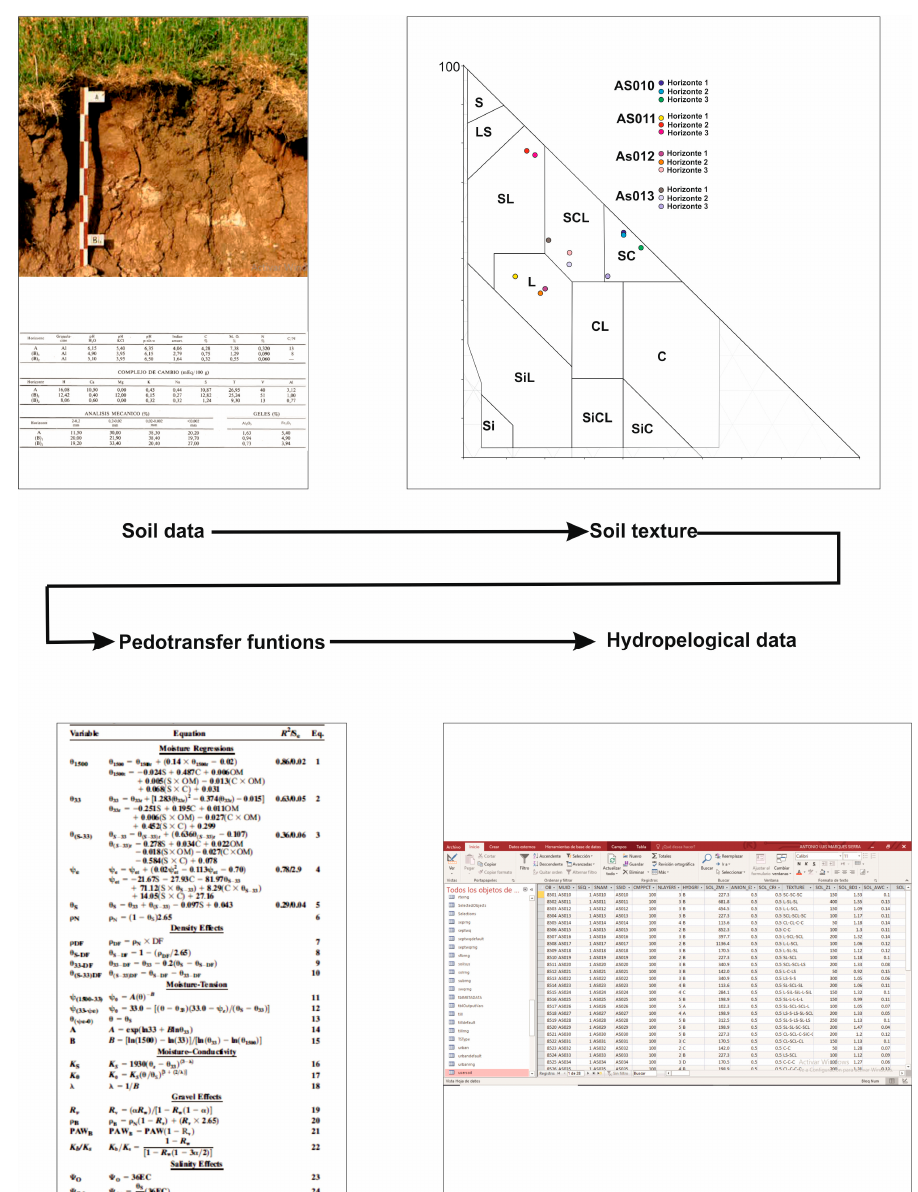
Figure 2. Methodology for hydropedology data determination for a single soil